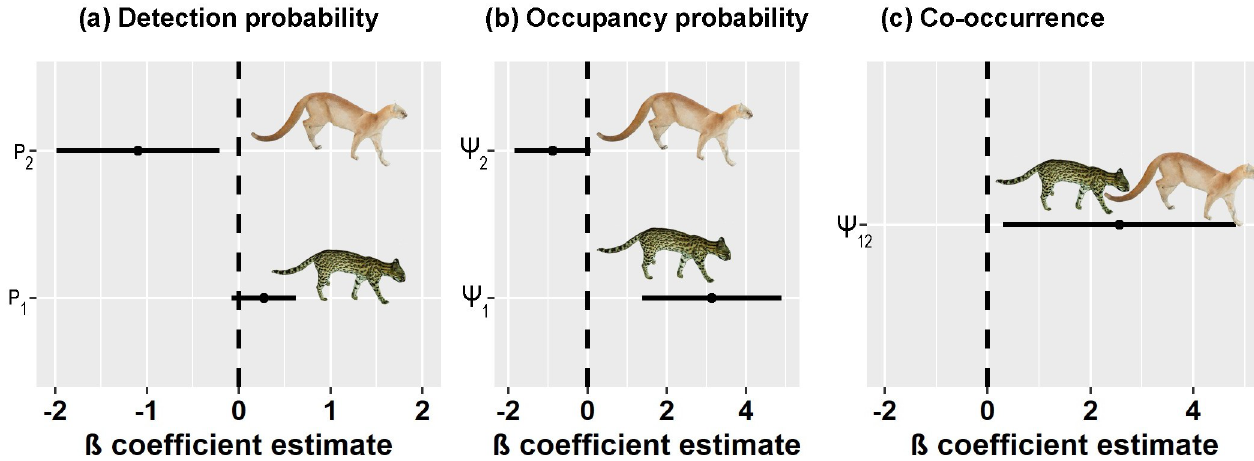
Fig 2. Species responses to covariates. (a) Detection probabilities in response to distance to water sources; (b) Occupancy probabilities in response to C 1 (percent tree cover), C 2 (distance to nearest plantations); (c) Pairwise co-occurrence